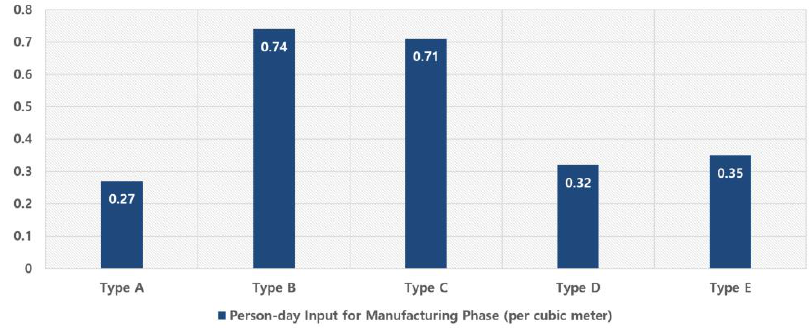
Figure 8. Manufacturing cost analysis (person-day input for manufacturing phase).